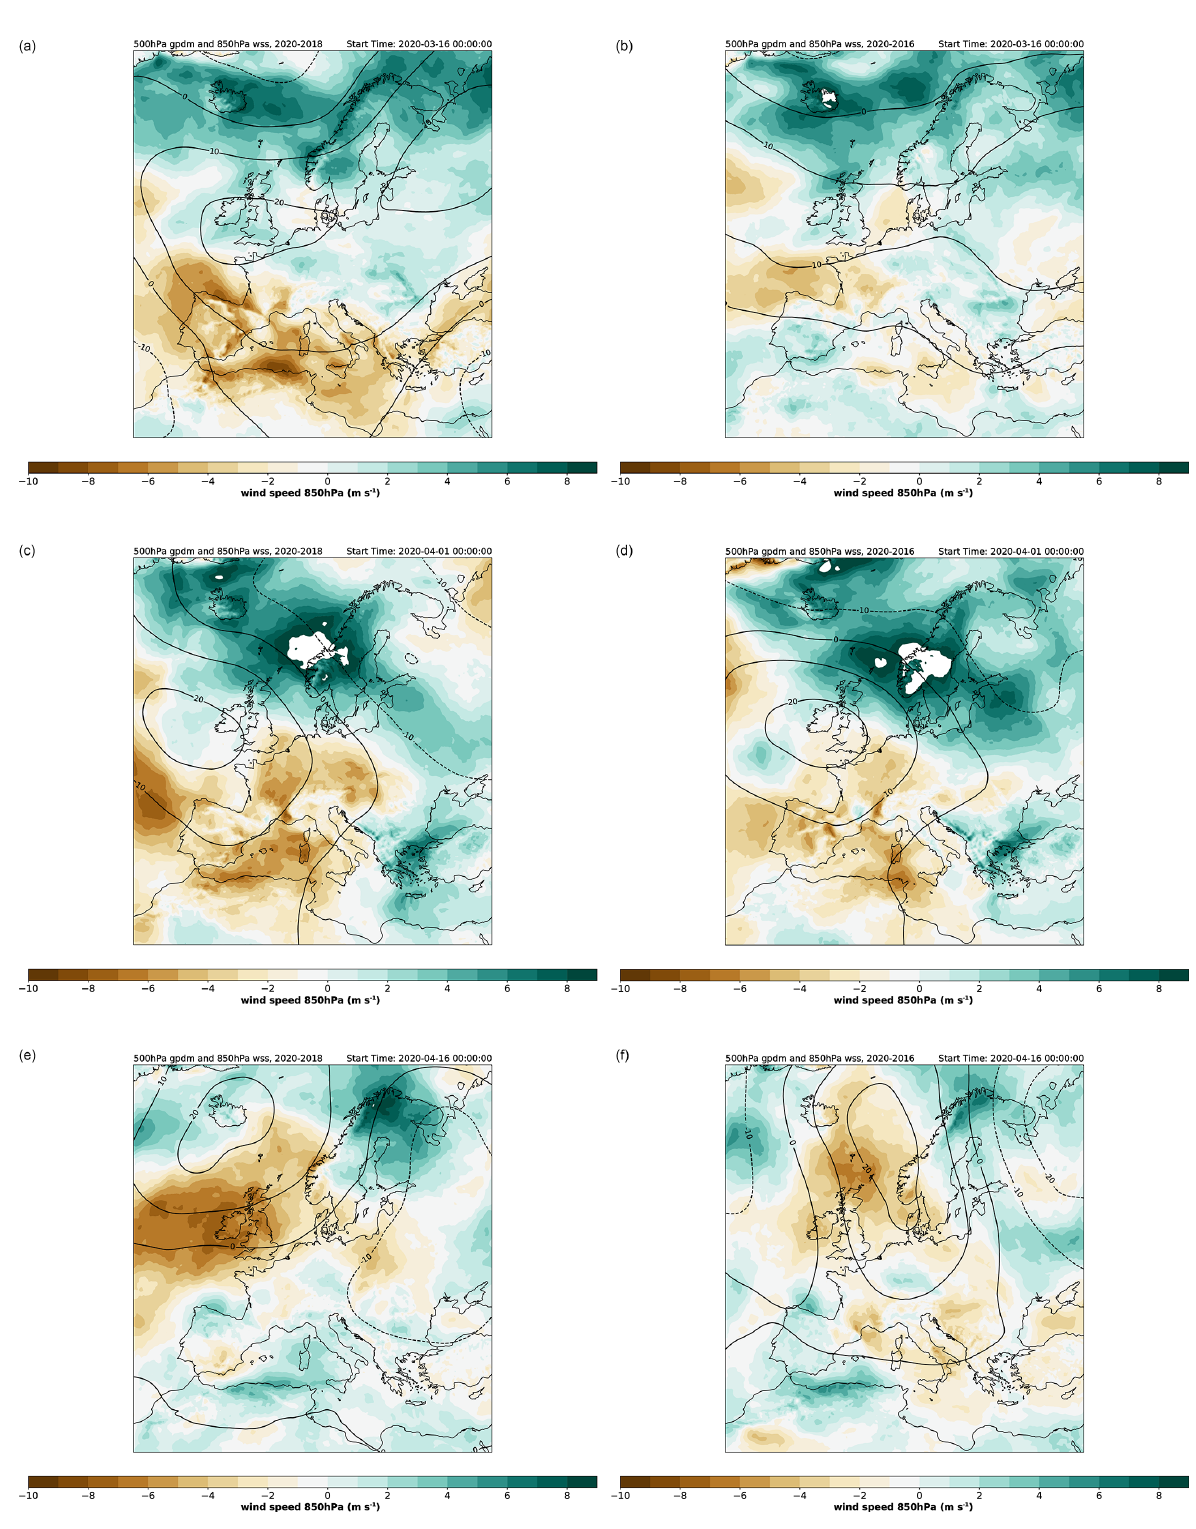
Figure A13. Geopotential height at 500hPa (in gpdm, isolines) and wind speed at 850hPa (in ms − 1 , colour code): differences between 2020 and 2018 (a, c, e) and between 2020 and 2016 (b, d, f) for the half-month periods 16–31 March (a, b) , 1–15 April (c, d) and 16–30 April (e, f) .